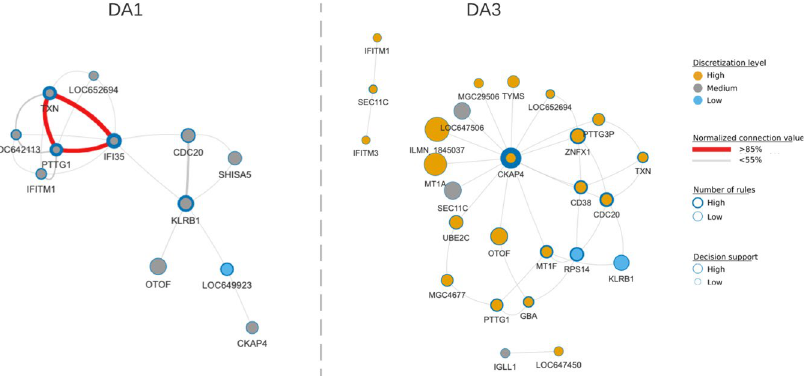
Figure 2. The rule networks discern the disease states. DA1 is largely defined by medium gene expression, whereas DA3 includes more genes, and those that were highly expressed. For each decision class, internal node colour indicates discretised gene expression value (high, medium, low; orange, grey, blue), node size is proportional to the number of objects supporting rules associated to a node, node border thickness is proportional to the number of rules associated to a node (low, high; circle border thin, thick) and edges connecting nodes represent normalised connection values (< 55%, ≥ 85%; grey, red with increasing line thickness per support interval). The latter is the strength of the co-appearance of connected nodes in rules supporting a decision class. The network was filtered to visualise rules with minimum support of 10% and rule p-value ≤